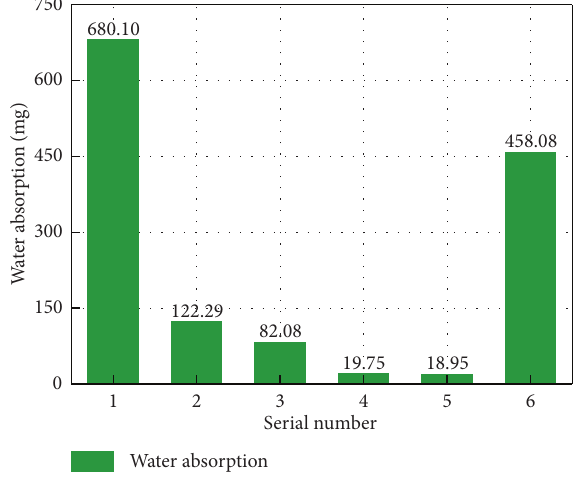
Figure 11: Water absorptions of different coal dust